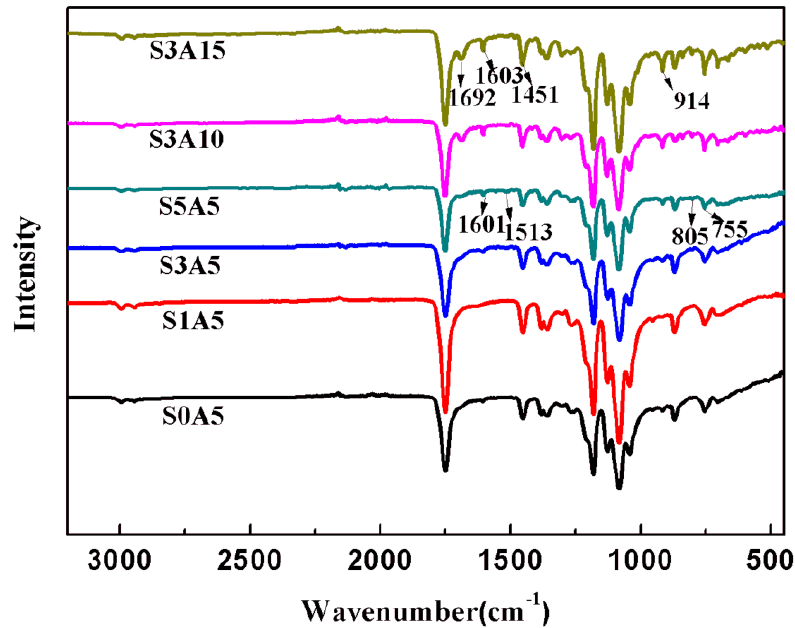
Figure 4. FTIR of the dual drug ‐ loaded biomimetic composite scaffold.